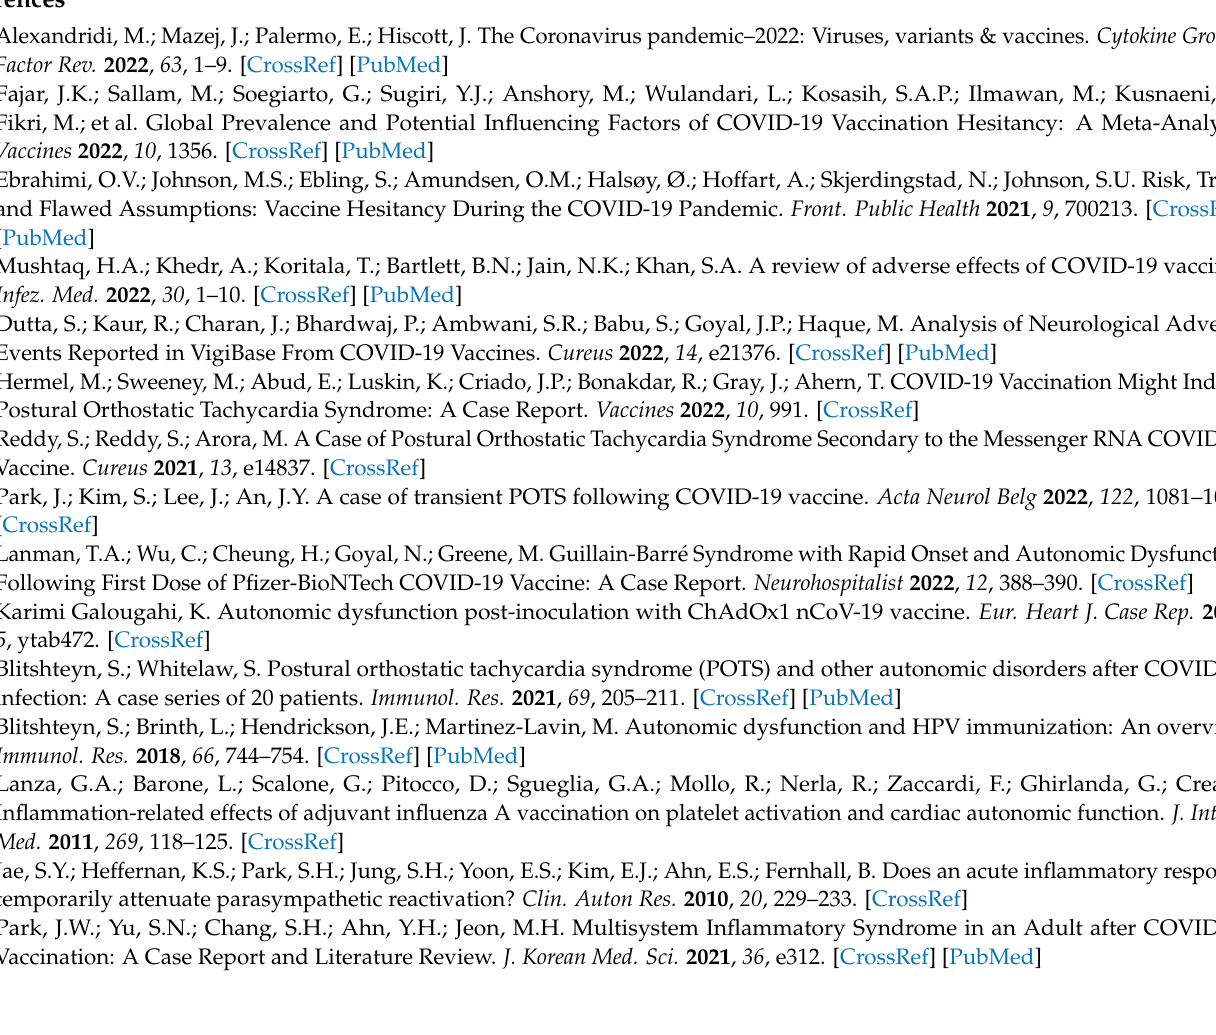
Table S2: Search strategies used in each database; Figure S1: Meta-analysis on RMSSD (ms) after vaccination data from Presby et al.